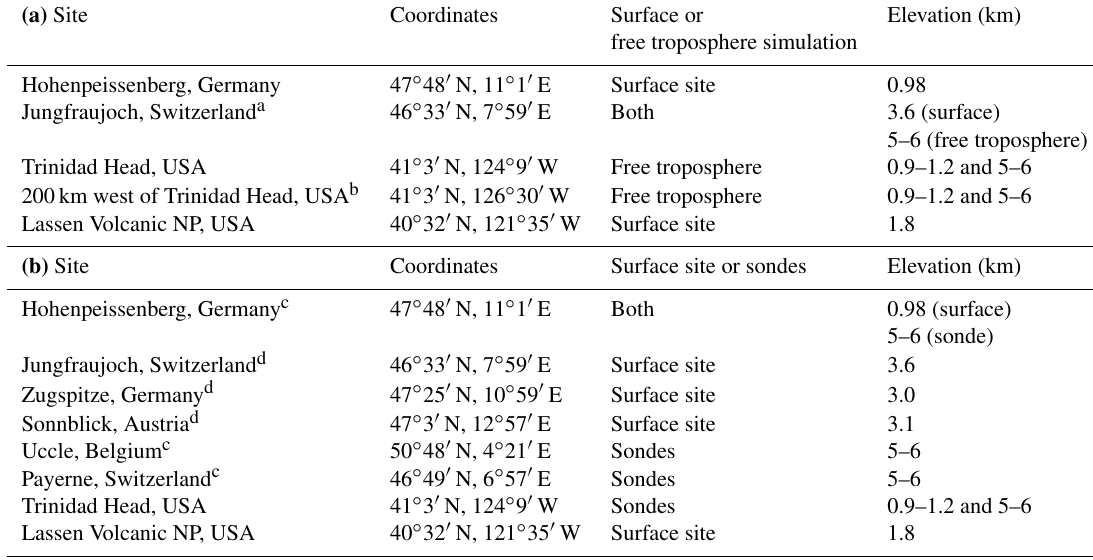
Table 1. (a) Location of model simulations included in seasonal cycle analysis. (b) Location of measurements included in seasonal cycle analysis.